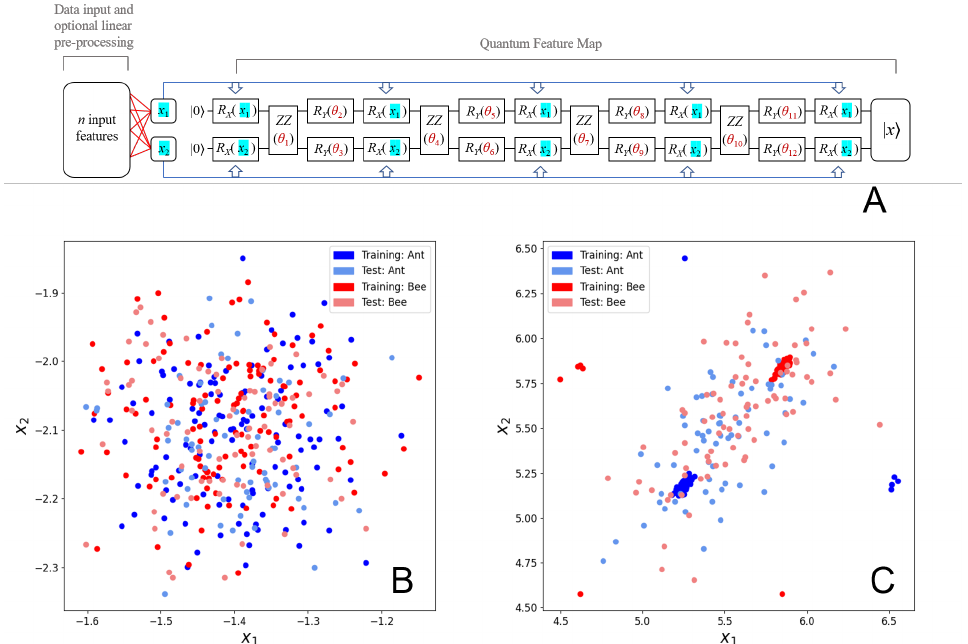
Figure 1. Diagrams illustrating the training process and results of the quantum feature map: ( A ) Di- agram of the general quantum metric embedding used. The model takes n classical input features and reduces them to two intermediary values ( x 1 and x 2 ) through matrix multiplication with a 2 × n parameter matrix, whose elements behave as trainable linear parameters. Thus, n input features yield 2 n trainable linear parameters. The resulting intermediate ( x 1 , x 2 ) values are then used as input alongside 12 trainable ’quantum’ parameters ( θ 1 – θ 12 ) to progress through the quantum feature map. Each sample ultimately ends up in the embedded | x (cid:105) state in which the Hilbert-Schmidt distance between different classes is maximized through iterative training of the linear and quantum parameters. The illustrated approach represents a generalized adaption of the hybrid quantum metric learning embedding used by Lloyd et al. [26] ( B ) Scatter plot of the ( x 1 , x 2 ) values of the Hymenoptera dataset with 512 ResNet features (corresponding to 1024 trainable linear parameters) after 0 steps of training. Datapoints from both the training set and the test set are depicted. We note that we used precisely the same train and test samples as in the original study [26] for the Hymenoptera data which corresponded to 61% train and 39% test. ( C ) Scatter plot of the ( x 1 , x 2 ) values of the Hymenoptera dataset with 512 ResNet features after 1500 steps of training using the PennyLane software package [40]. Datapoints from both the training set and the test set are